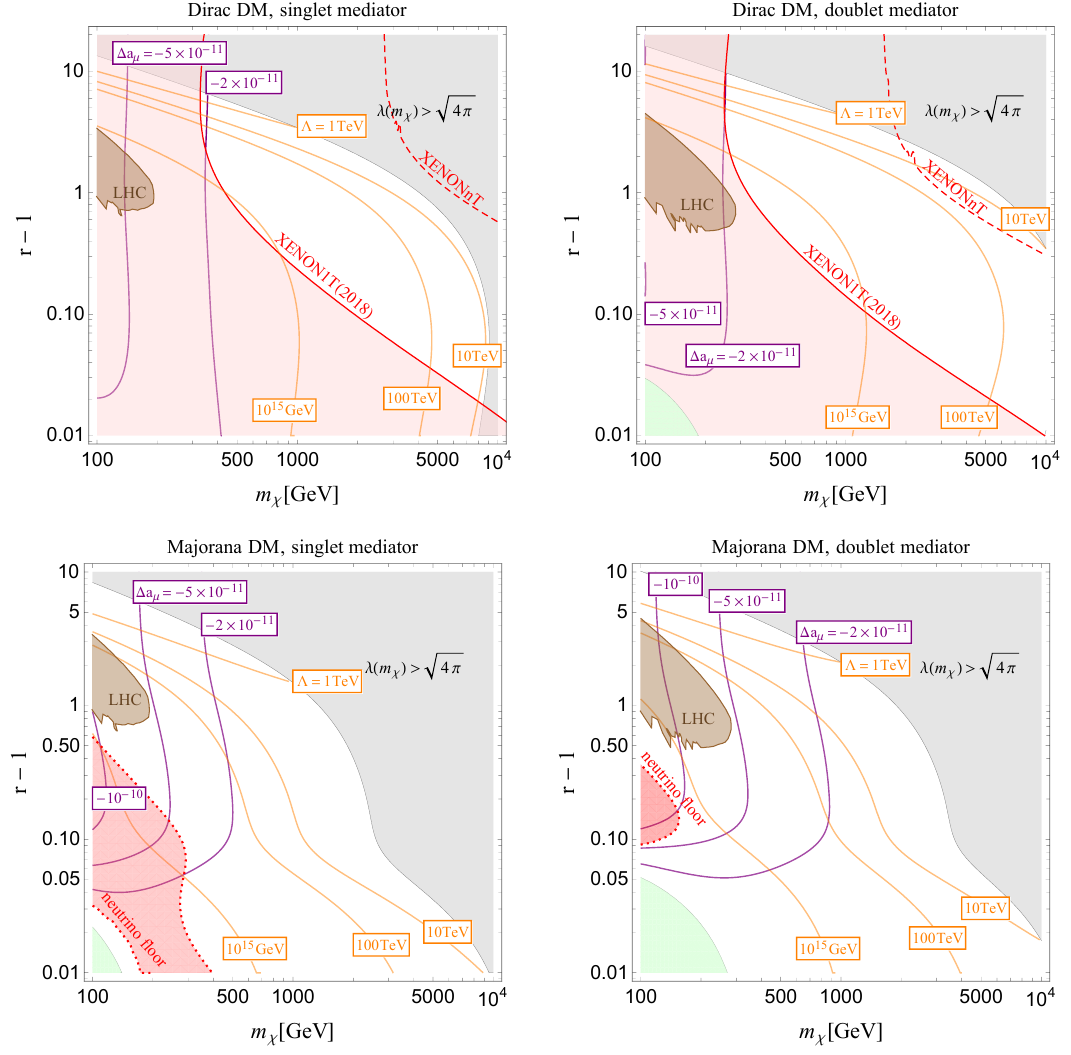
Figure 8 . Plots for the fermion DM models with the same constraints as in (cid:12)gure 7. The top (bottom) panels are for the Dirac (Majorana) fermion DM and the left (right) panels are for the singlet (doublet)